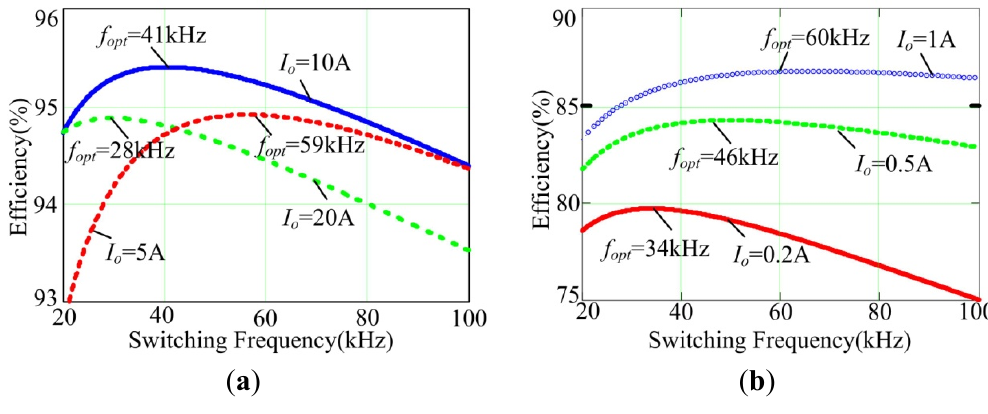
Figure 10. Efficiency versus frequency at different load currents ( a ) CCM; ( b )